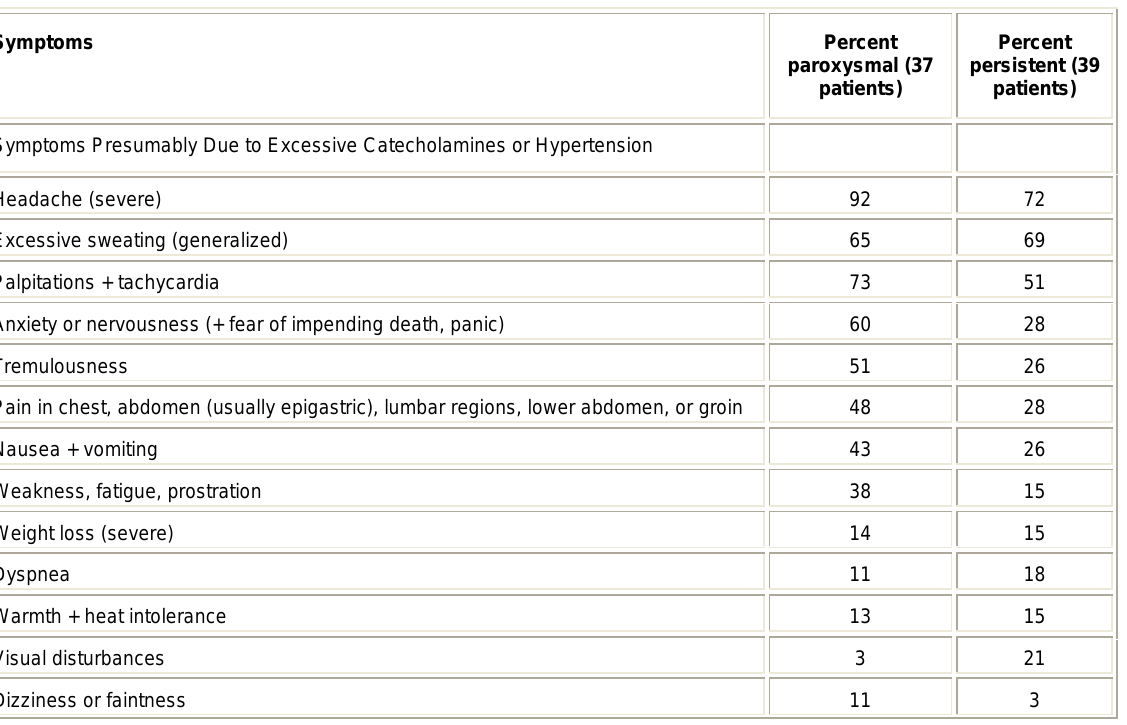
Symptoms Reported by 76 Patients (Almost All Adults) with Pheochromocytoma Associated